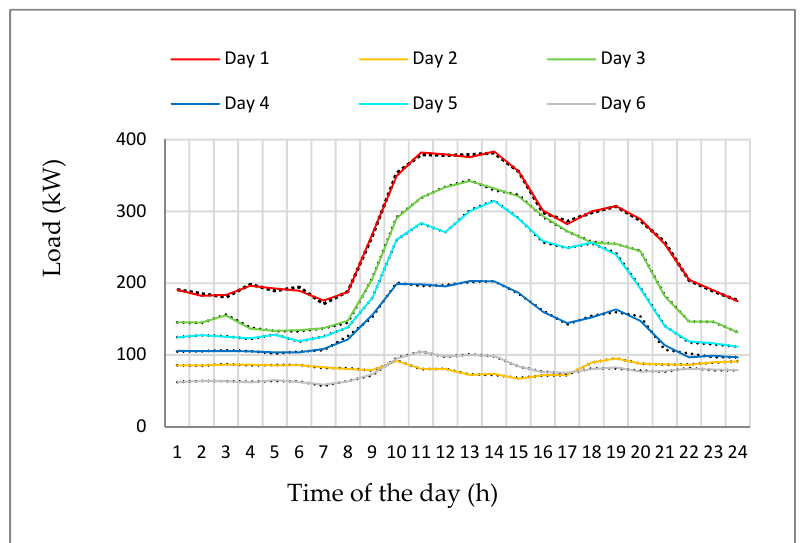
Figure 3. Measured (solid line) and simulated (dotted line) load curves for six di ff erent days of the year.